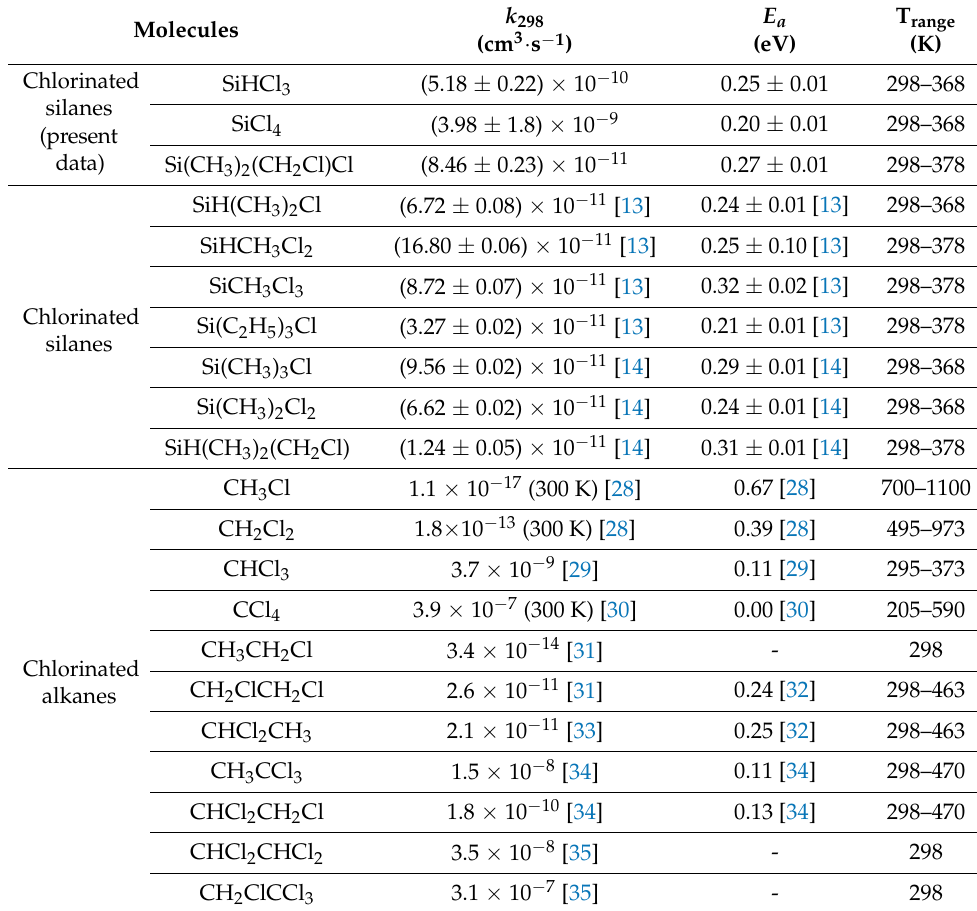
Table 1. Thermal electron attachment rate coefficients ( k 298 ) at 298 K and activation energies ( E a ) for all of the investigated chlorosilanes and literature data for the selected chlorinated silanes and alkanes. T range corresponds to the temperature range in which E a were